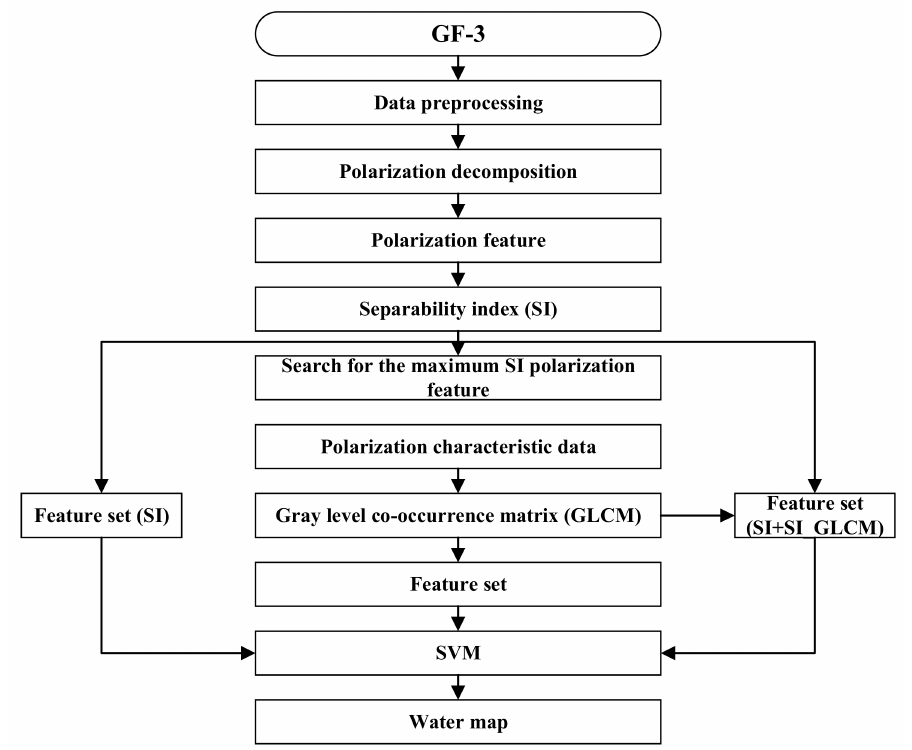
Figure 2. Technology